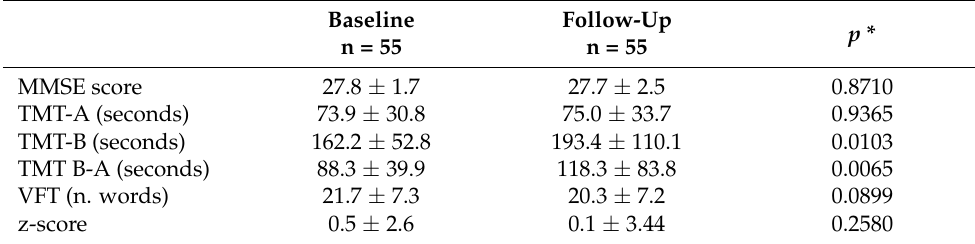
Table 4. Neuropsychological test scores at baseline and follow-up.